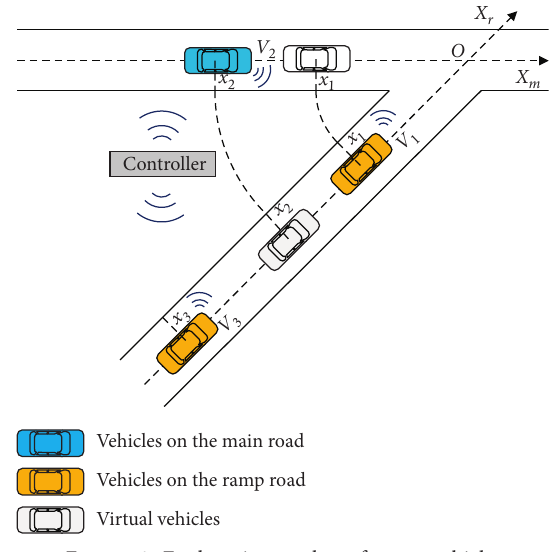
Figure 3: Explanation to the reference